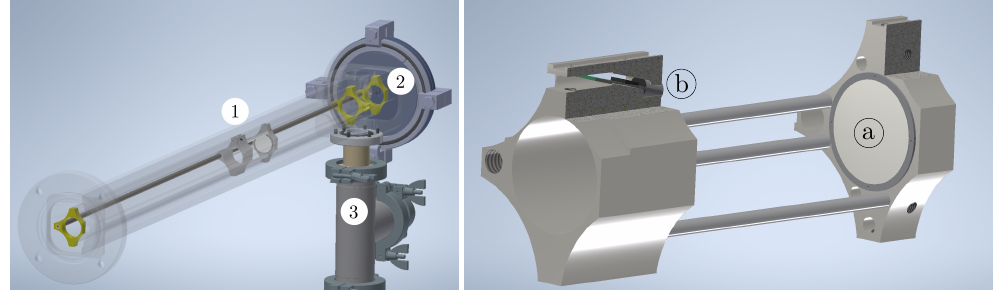
Figure 2. 3D view of the π 3 detector mounted inside of the MBL beampipe ( left ). The moving support (1), the position of the motor behind the vacuum feed-through (2) and the tube for the pulley system (3) are visible. The support holds the camera that looks towards the P47 coated aluminum foil. The beam comes from the left side. The magnet system of the MBL is not shown. Details of the moving support ( right ) featuring the scintillating foil (a) and the CCD